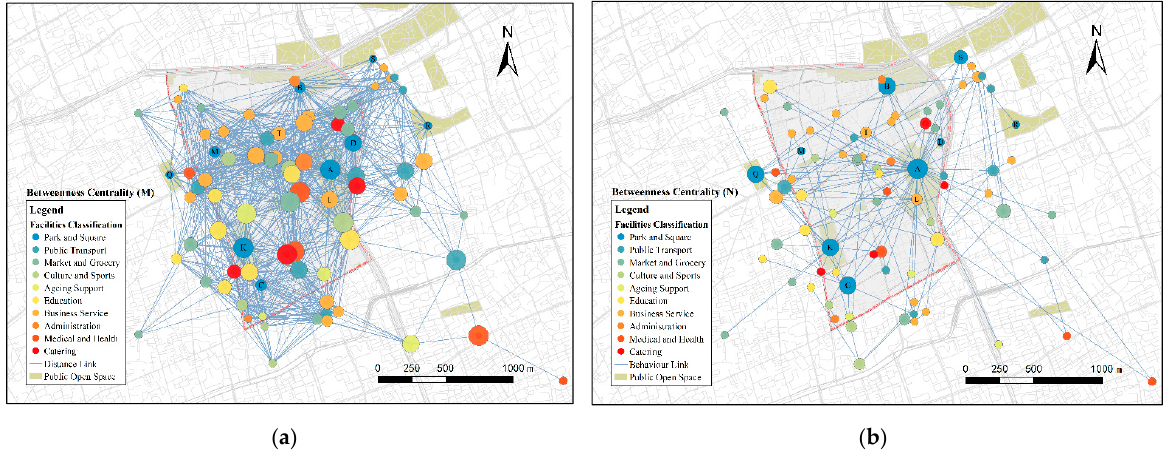
Figure 7. BC of nodes: ( a ) BC in the spatial network; ( b ) BC in the behaviour network. Table 5. Comparison of the POS centralities in the behaviour and spatial networks.